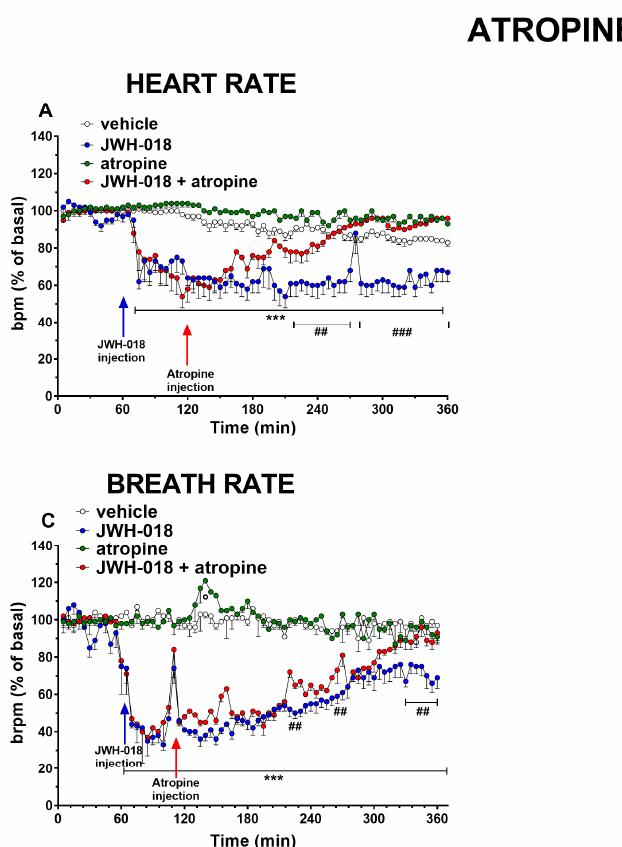
Figure 4E, significant effect of treatment (F 1,112 = 58.89, p < 0.0001), bin (F 7,112 = 10.74, p < 0.0001), and bin × treatment interaction (F 7,112 = 8.571, p < 0.0001); Figure 4F, signif- icant effect of treatment (F 1,112 = 87.34, p < 0.0001), bin (F 7,112 = 9.646, p < 0.0001), and bin × treatment interaction (F 7,112 = 9.995, p < 0.0001)).